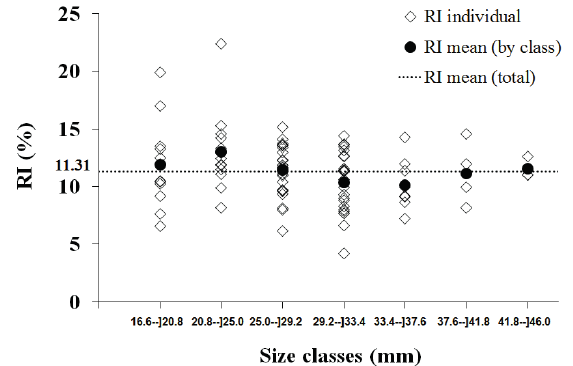
Figure 4. Eriphia gonagra (Fabricius, 1781). Reproductive investment (RI) by size class.